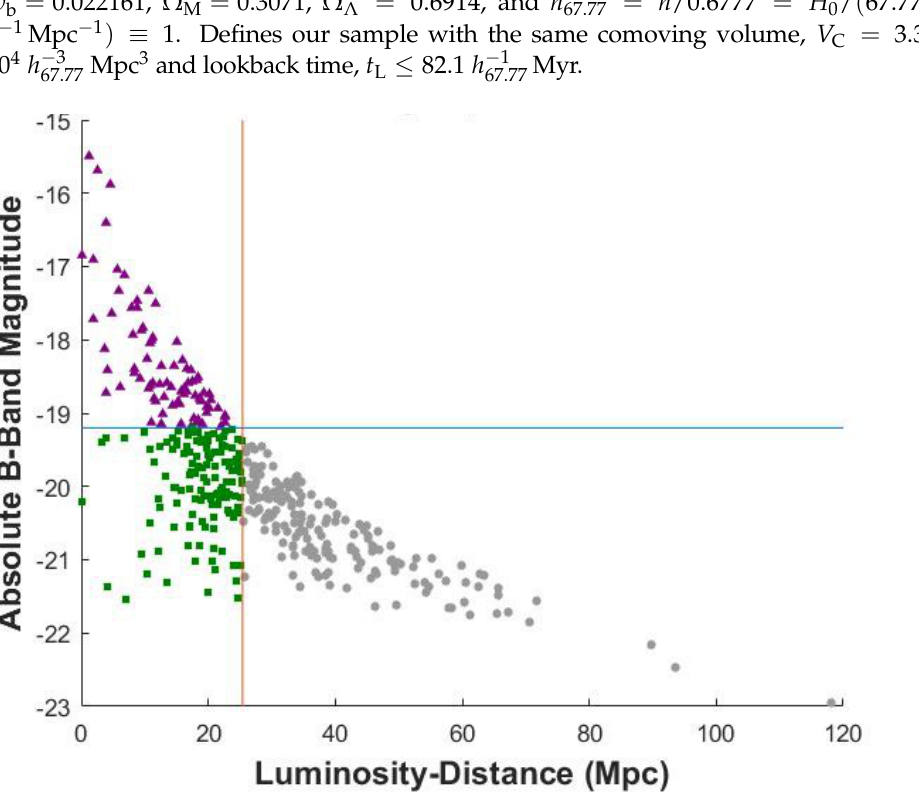
Figure 2. Luminosity distance vs. absolute B -band magnitude for the Carnegie-Irvine Galaxy Survey CGS [54] galaxies. The Davis et al. [53] sample (green squares, (cid:4) ) and our faint galaxy sample (purple triangles, (cid:78) ) are illustrated. The vertical ( ) line is positioned at D L = 25.4Mpc (gray circles, • right of this line represent galaxies that are too distant and thus, not included in either sample) and the horizontal ( ) line is positioned at M B = −